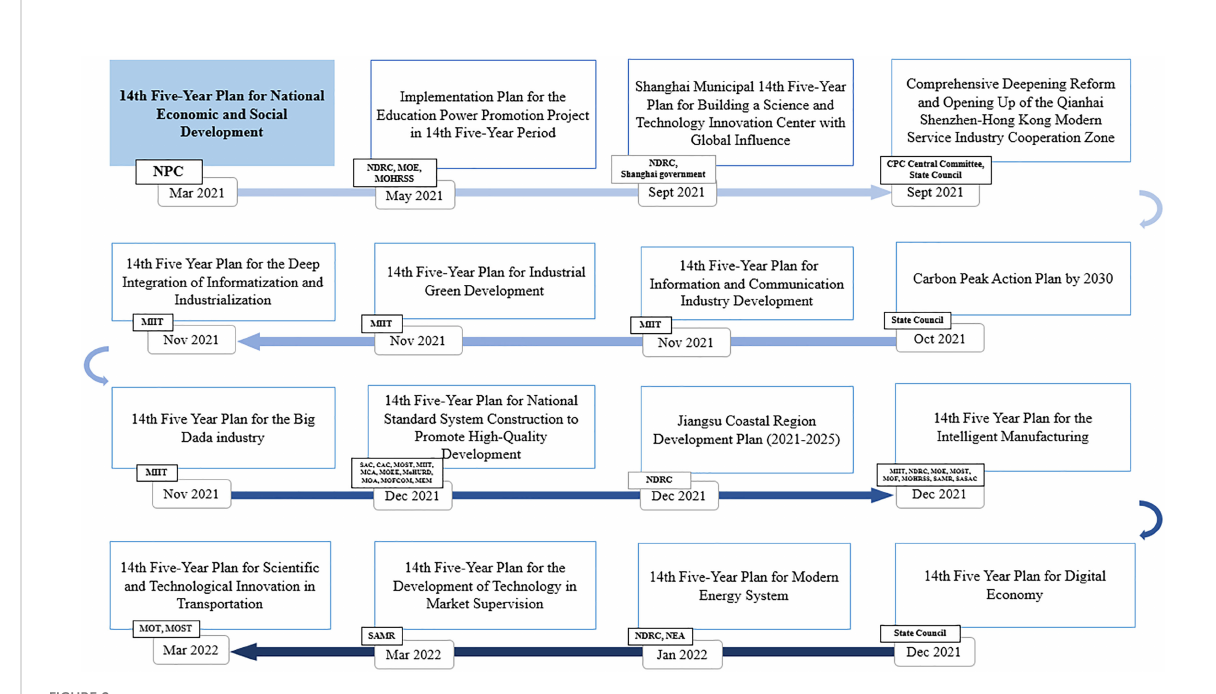
FIGURE 2 The central government ’ s 14th Five-Year Plans for the MEE industry. Source: Authors ’